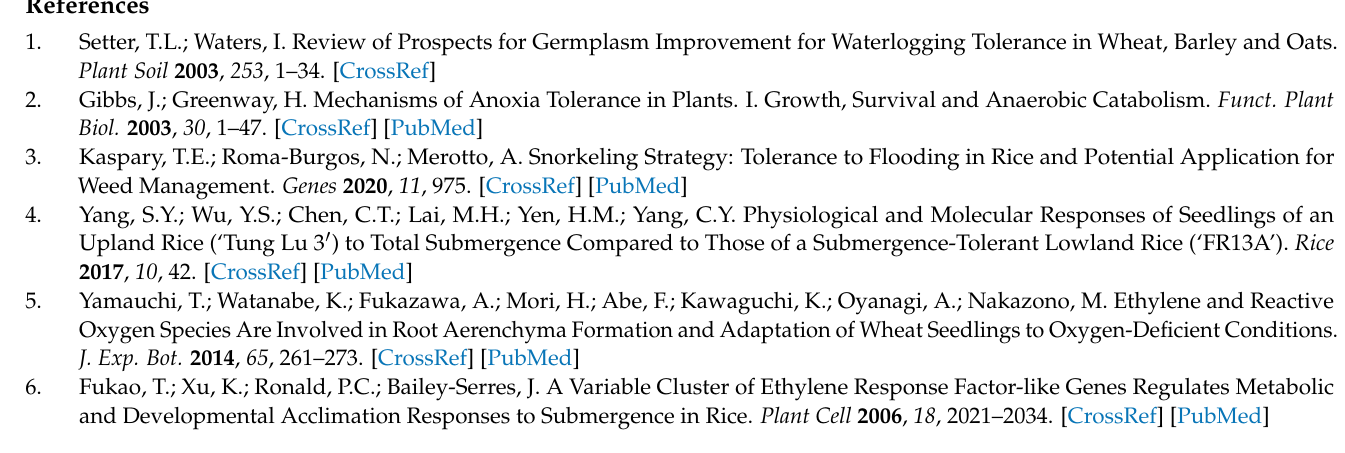
KEGG pathway results; Table S1: RNA-Seq analysis resulted; Table S2: DEGs connected to the method of antioxidant enzymes; Table S3: DEGs related to APX; Table S4: DEGs related to glutathione; Table S5: DEGs related to auxin; Table S6: The specific primers for genes involved in the hormone signaling